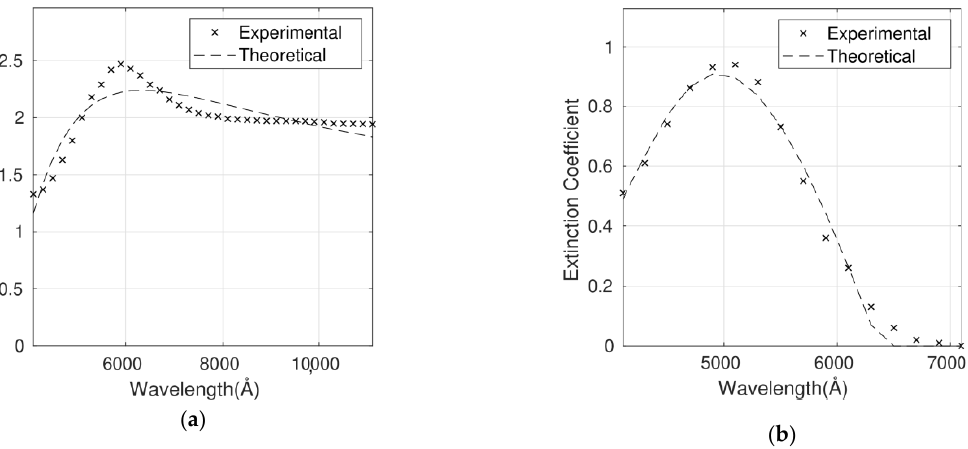
Figure 9. Refractive index ( a ) and extinction coefficient ( b ) fits to Cauchy’s equation for the P3HT/G (5 wt%) nanocomposite. Experimental data are adapted from Ref. [9] with permission from the American Institute of Physics, 2012.